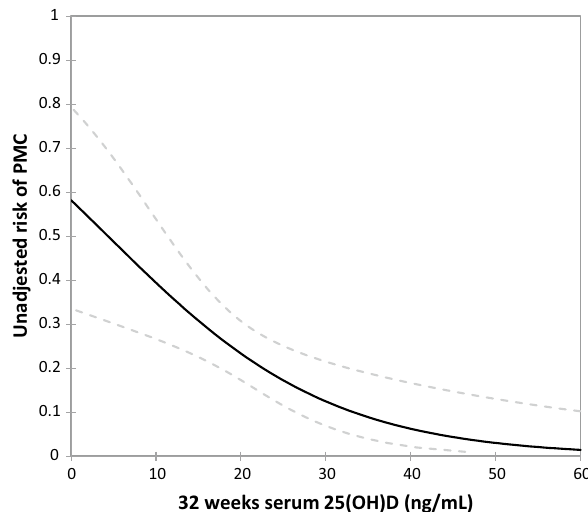
Figure 2. Dose–response association between maternal serum 25-hydroxyvitamin D concentration at 32 weeks and the risk of placenta mediated complications derived from a logistic regression model ( P = 0.001). The solid line represents the point estimate, and the dotted lines represent the 95% confidence bands.